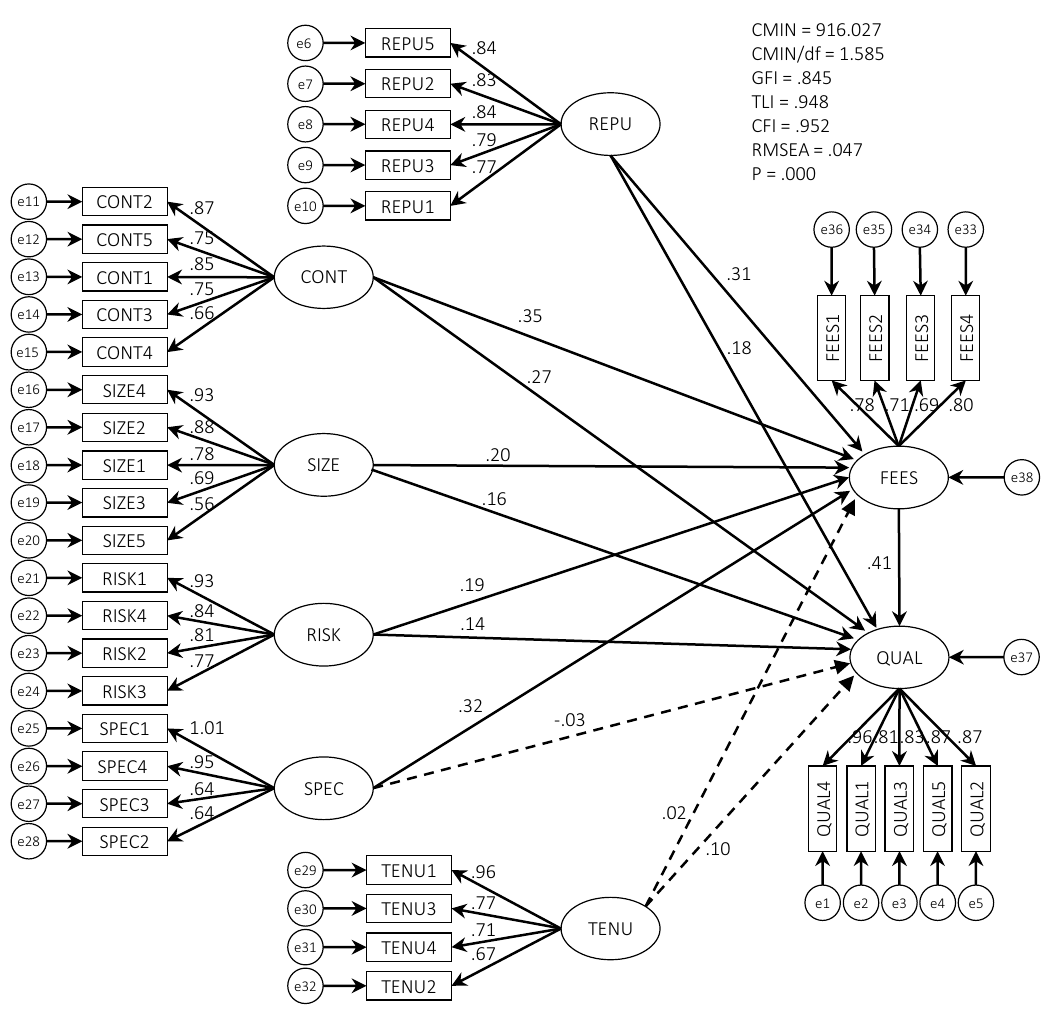
Figure 2. Results of the model testing (standardized) Table 4. Testing results about the correlation between terms in the model Source: AMOS output, 2021. Relationship Estimate S.E. C.R. P